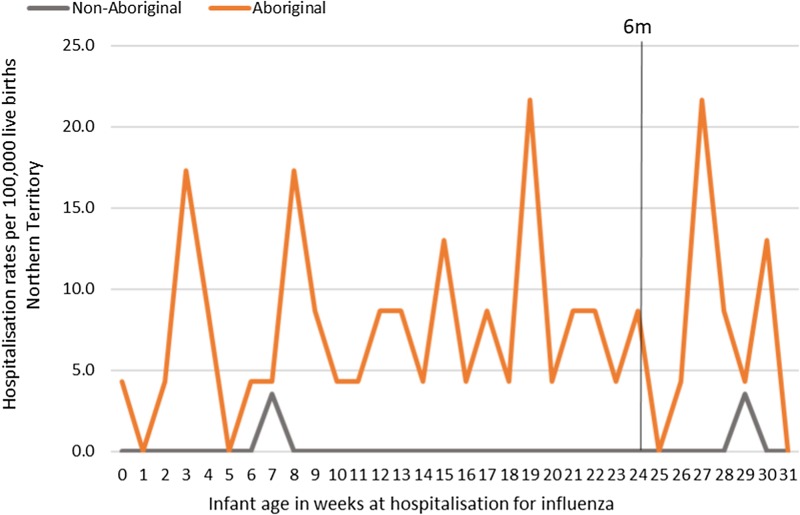
Influenza hospitalisation rates per 100 000 live births for infants 0–<7 months old, by week of infant birth, Northern Territory, Australia (2000–2014).